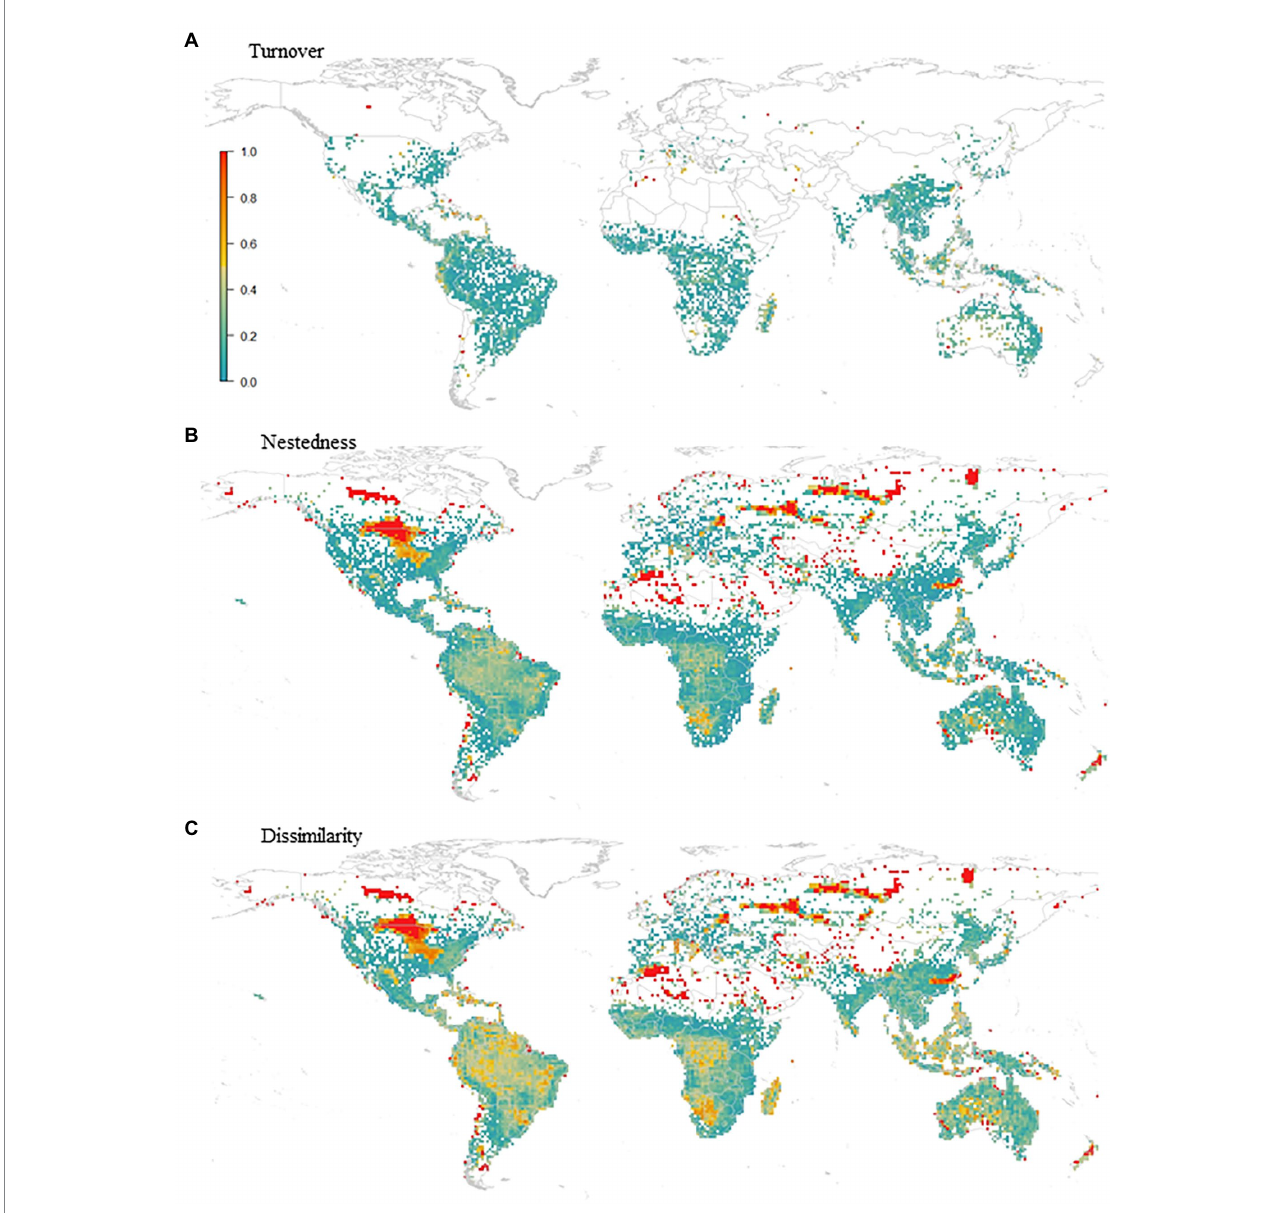
FIGURE 6 Temporal beta. Performance of (A) turnover - β sim, (B) nestedness - β sne and (C) dissimilarity - β sor, with β sim and β sne varying between β sor and 0. All variables are mutually dependent as β sor = β sim + β